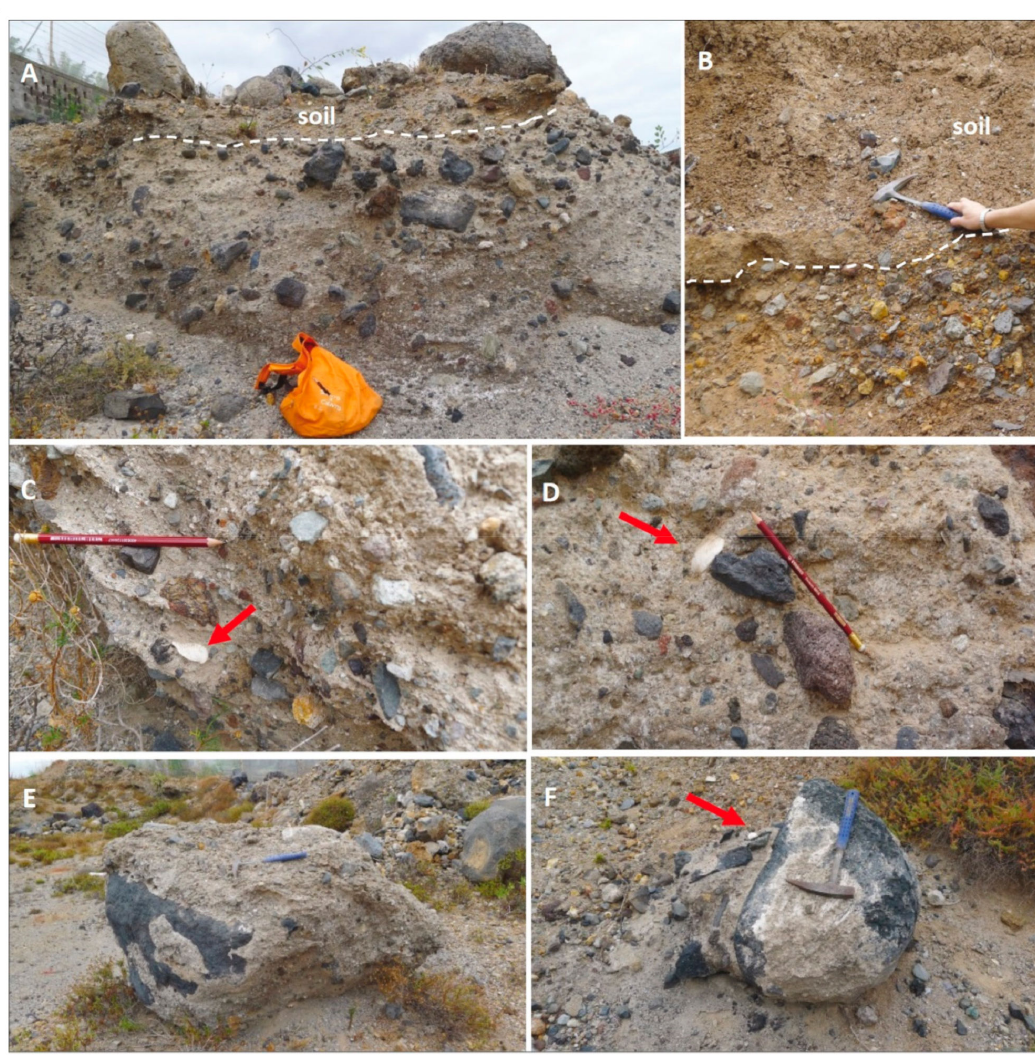
Figure 7. Tsunami deposits located inland on Isla Baja platform (Cenizales site, see map in Figure 5). ( A ) View of the upper breccia with cm- to dm-sized heterolithic clasts, and ( B ) detail of this layer in the uppermost zone, with smaller heterometric clasts in an ash matrix. ( C , D ) Detail of the heterolithic layer containing Glycymeris valves among the clasts; ( E , F ) large basalt boulders from the lower layer, up to 0.4 m 3 , covered by consolidated marine sandstone and remnants of a cemented sandy-ash matrix containing angular basalt clasts and marine shells fragments. Note: the large boulders of the upper part in ( A ) are not in